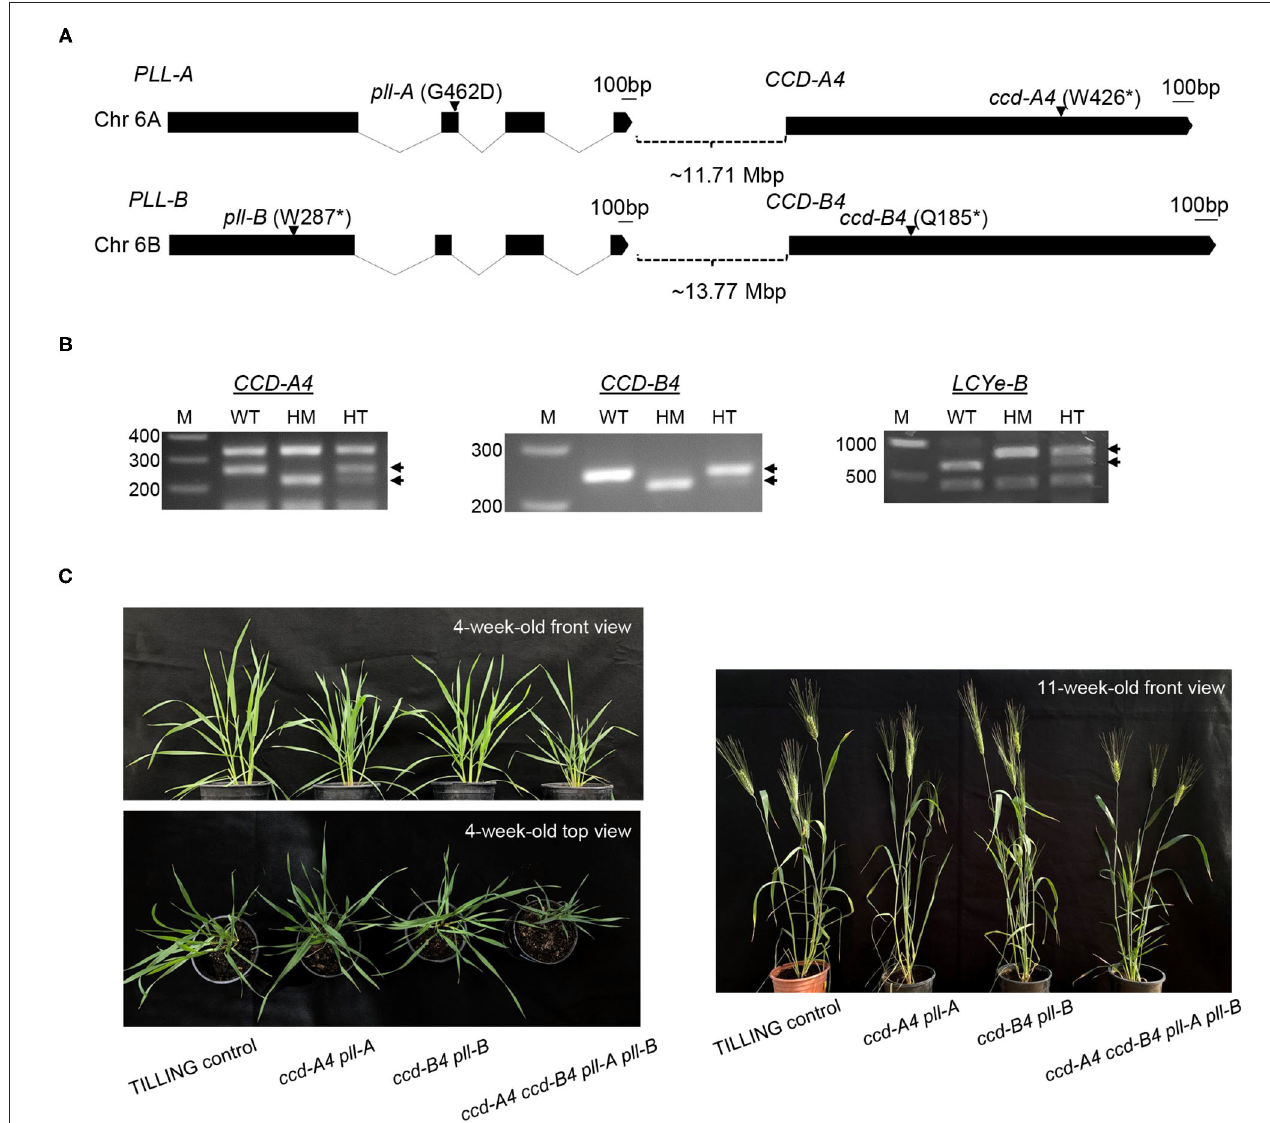
FIGURE 1 | Tetraploid wheat TILLING mutants of CCD-A4 , CCD-B4 , PLL-A , and PLL-B . (A) Exon-intron diagrams of CCD-A4 , CCD-B4 , PLL-A , and PLL-B . Exons and introns are shown by black boxes and solid lines, respectively. The black bar denotes 100 bp. Locations of mutations are indicated with arrows. Mutant alleles of CCD4 and PLL homoeologs are linked and co-segregated in progenies of ccd-A4 and ccd-B4 mutants. Chr, chromosome; Mbp, megabase pair; *stop codon. (B) Cleaved Amplified Polymorphic Sequences (CAPS) and derived CAPS (dCAPS) markers for genotyping of wild-type and mutant CCD-A4 , CCD-B4 , and LCYe-B alleles. The PCR products were digested with HphI ( CCD-A4 primer pair), RsaI ( CCD-B4 primer pair), and DdeI ( LCYe-B primer pair). Diagnostic bands for each marker are indicated with arrows. WT, homozygous wild type for the target gene; HM, homozygous mutant; HT, heterozygous mutant; M, DNA size marker. (C) Images of 4-week-old and 11-week-old TILLING control as well as ccd-A4 pll-A , ccd-B4 pll-B , and ccd-A4 ccd-B4 pll-A pll-B mutant plants.